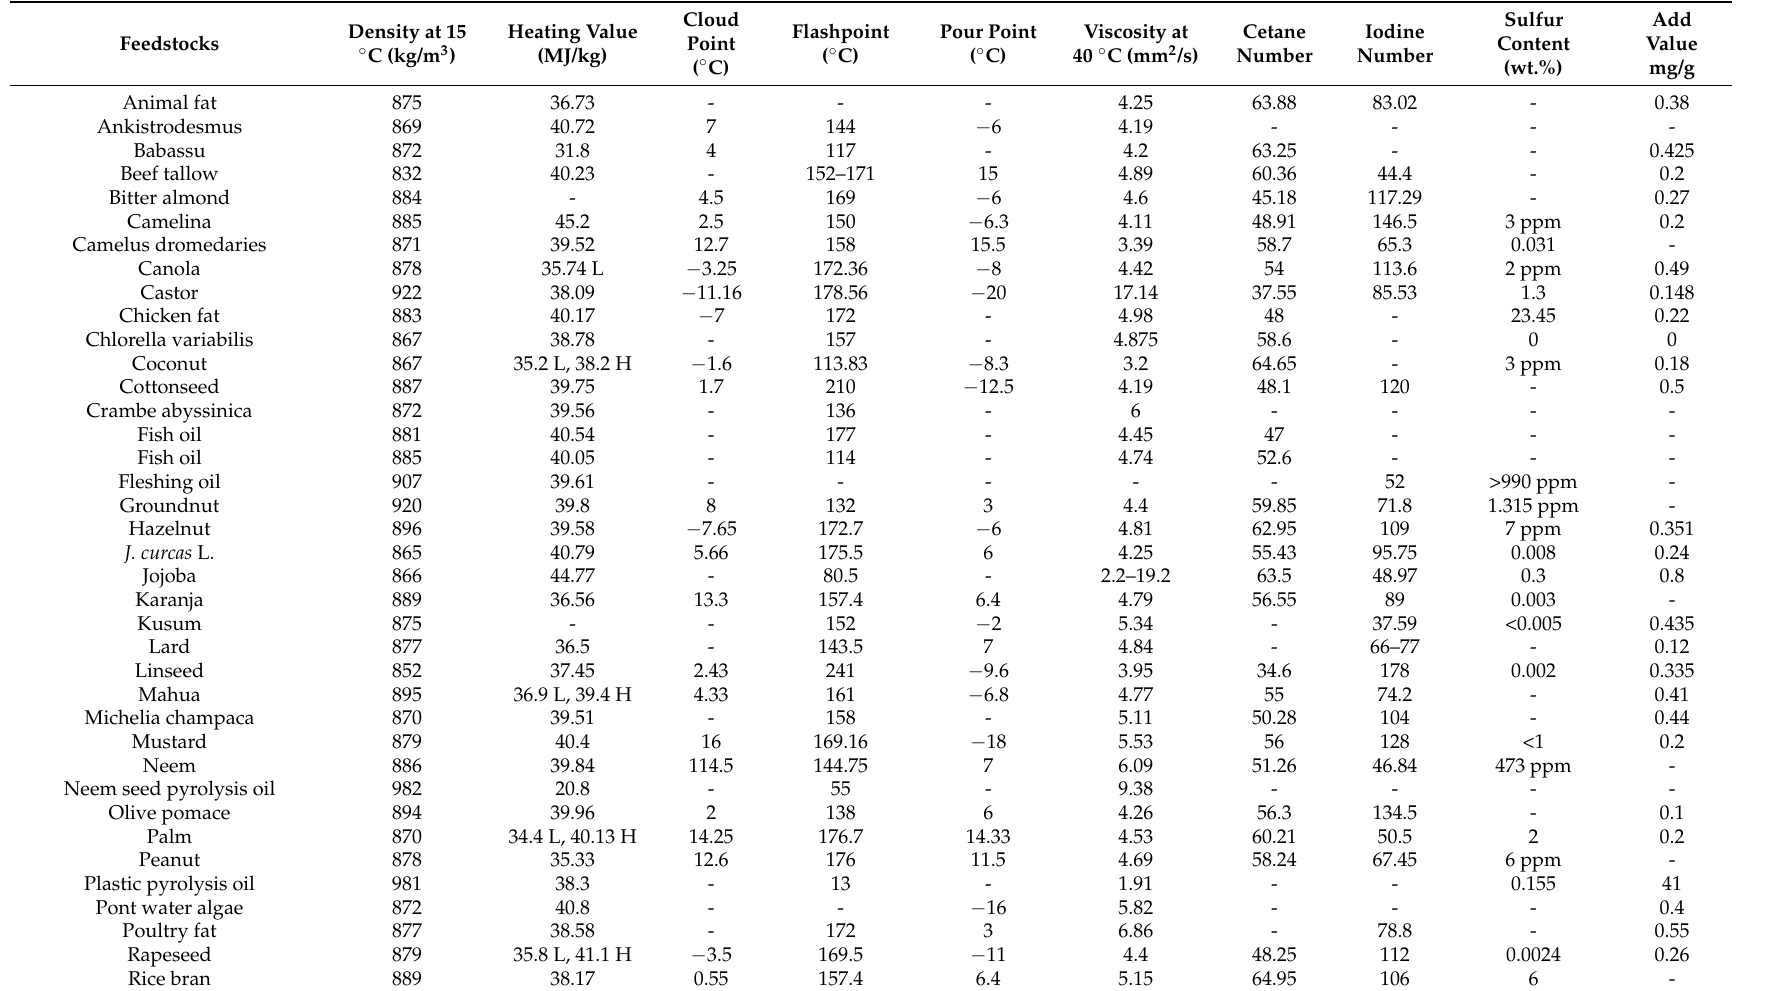
Table 3. Fuel properties of biodiesel derived from different generation oil feedstock. This information is adapted from Singh et al. [81]. Feedstocks Animal